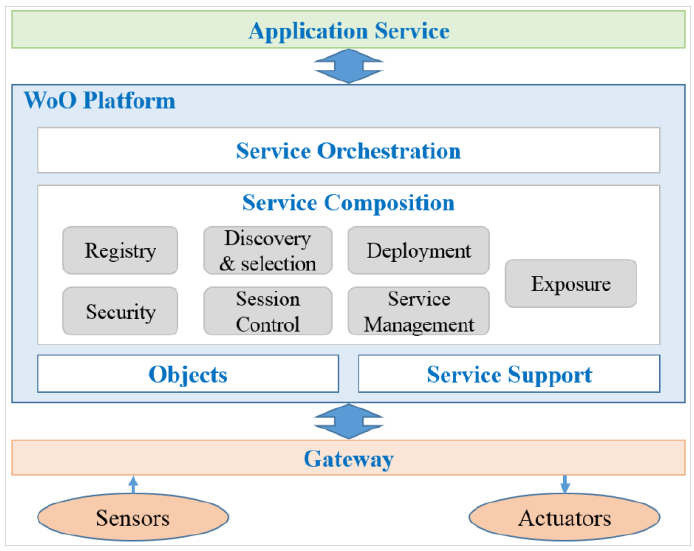
Figure 12. Functional architecture of WoO platform for service